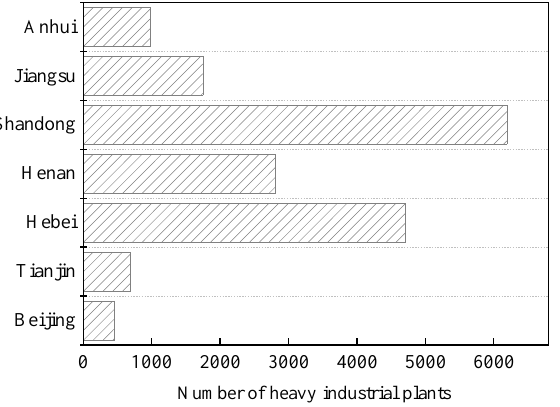
Figure 6. Number of heavy industrial plants in each province of the NCP.